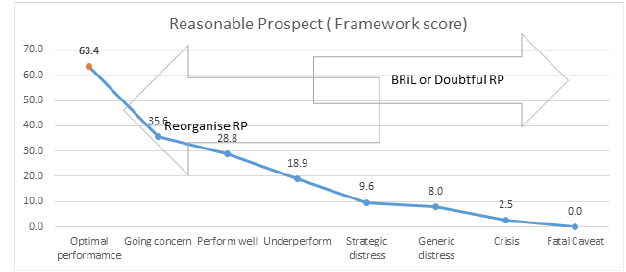
Figure I: Reasonable prospect assessment with RPA scores to guide